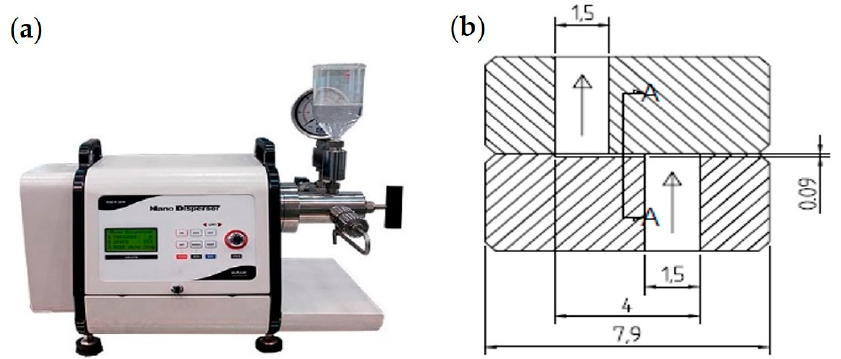
Figure 1. Scheme of the equipment used in this study: ( a ) electric motor-driven high-pressure homogenizer, and ( b ) Diacell ® Z-type nozzle (unit in mm).